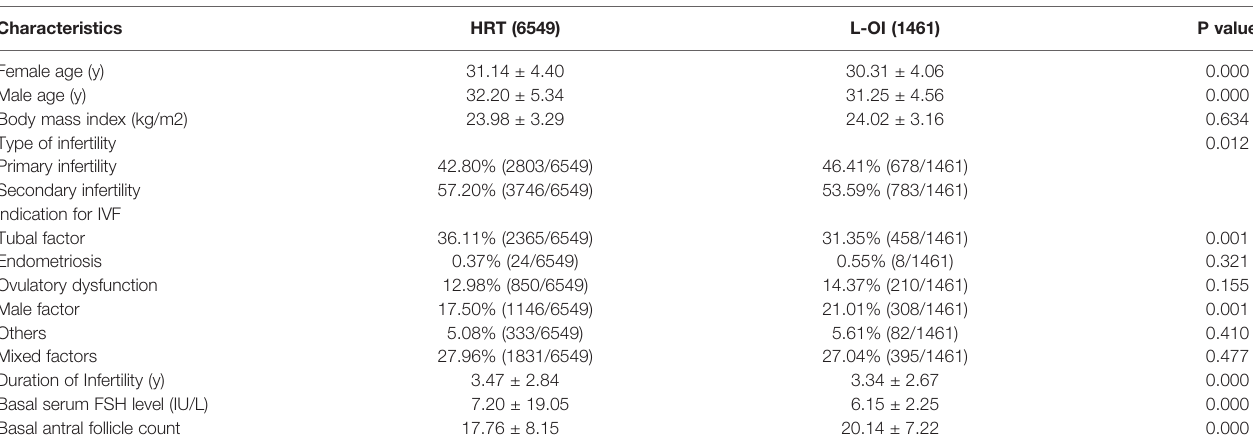
TABLE 1 | Patient clinical